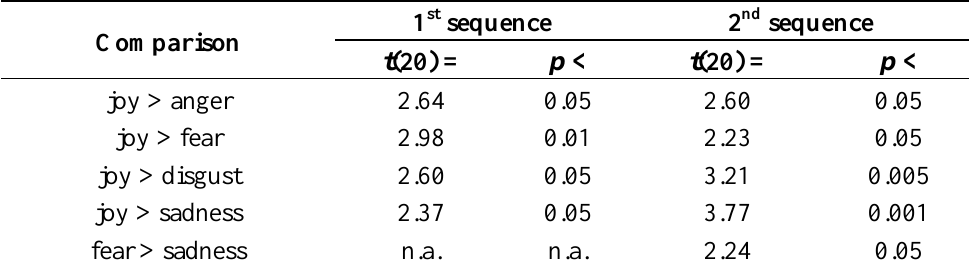
Table 6. Within category comparison for